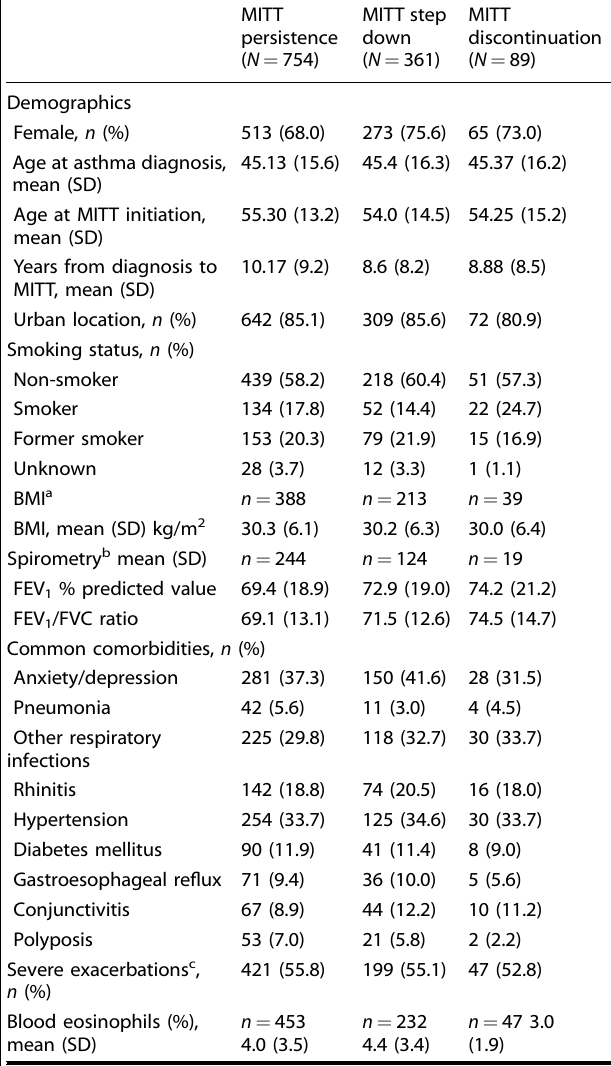
Table 3. Characteristics of patients with severe exacerbations in the 12 months prior to MITT initiation and 12 months following MITT